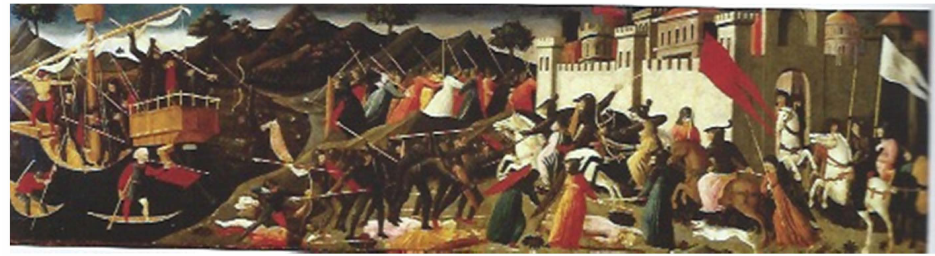
Figure 1. Domenico di Michelino. Teseida : Battle of Theseus and the Amazons . c.1450.